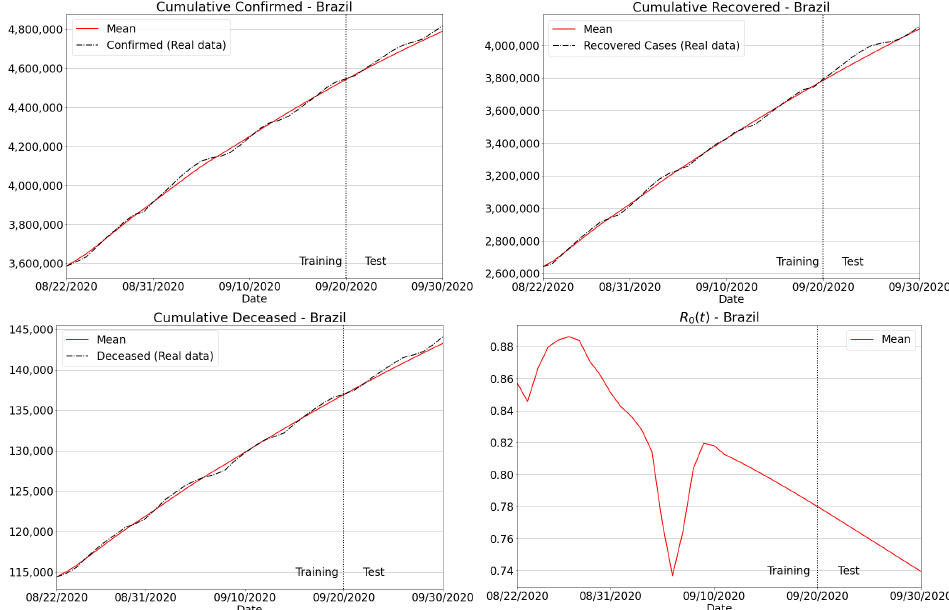
Figure 12. Forecasting results for